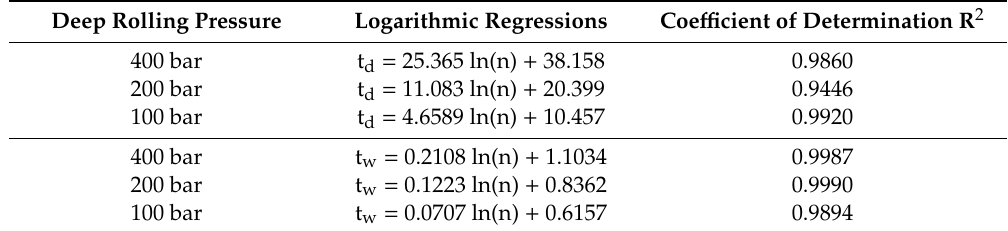
Table 5. Logarithmic regressions for n ≥ 1 of the track depths and the track widths in Figure 3. Deep Rolling